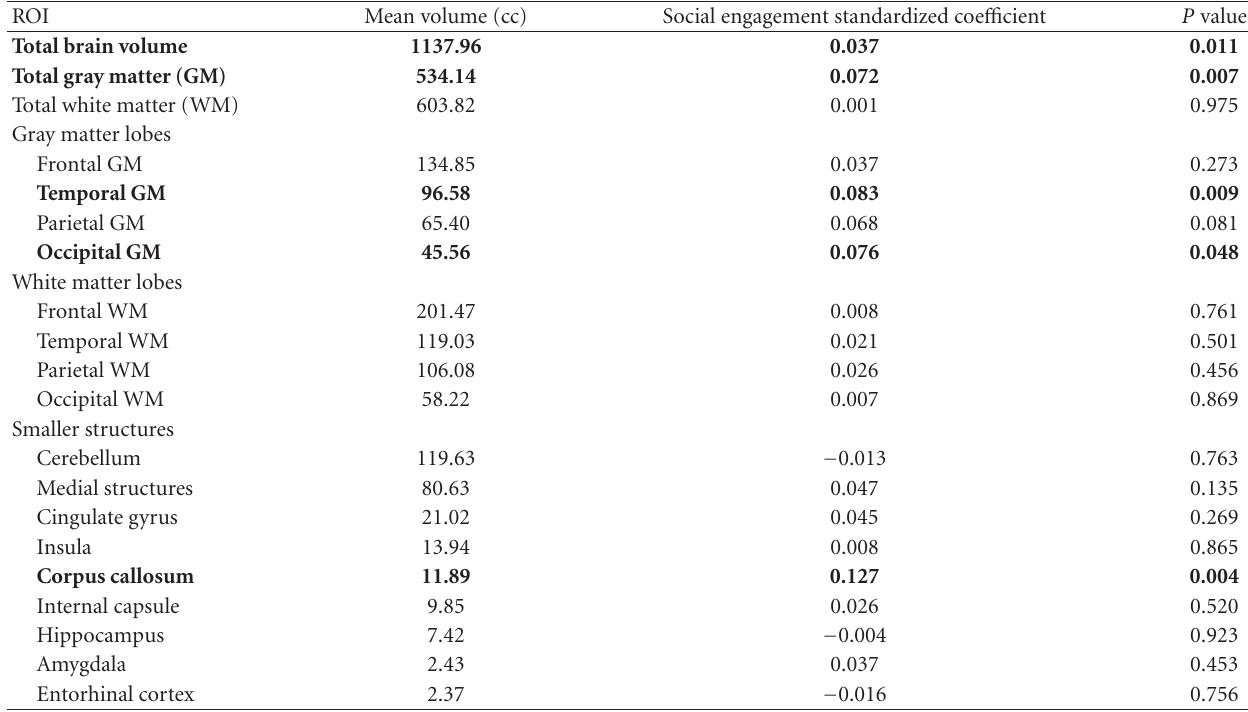
Table 2: Adjusted associations between social engagement (independent variable) and ROI volumes (dependent variables).